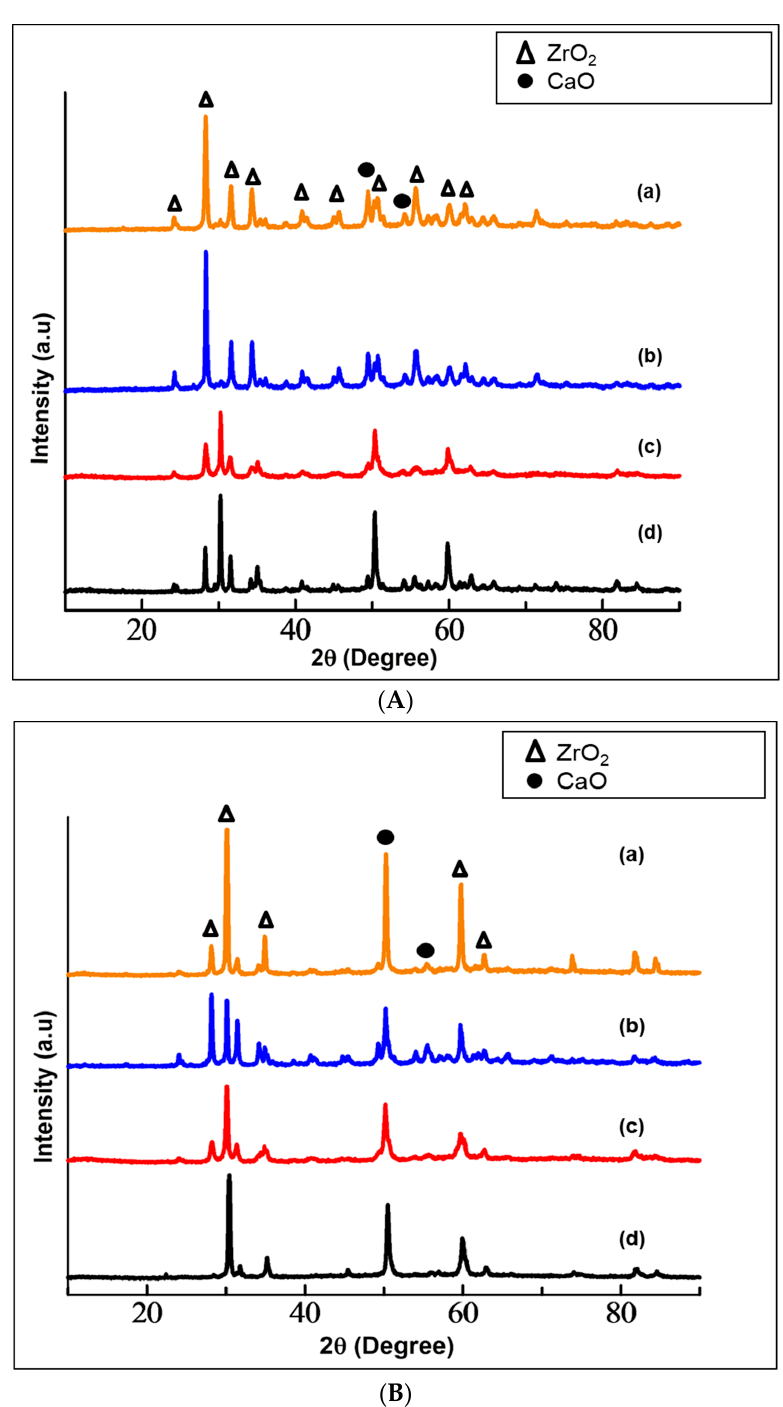
Figure 2. ( A ) XRD patterns of calcia-stabilized zirconia with CaO derived from cockle shells (Ca-SZ(CS)) sintered for 2 h at ( a ) 1500 ◦ C; ( b ) 1400 ◦ C; ( c ) 1300 ◦ C; ( d ) 1200 ◦ C. ( B ) XRD patterns of calcia-stabilized zirconia with CaO derived from commercial CaO (Ca-SZ(CC)) sintered for 2 h at ( a ) 1500 ◦ C; ( b ) 1400 ◦ C; ( b ) 1300 ◦ C; ( d ) 1200 ◦